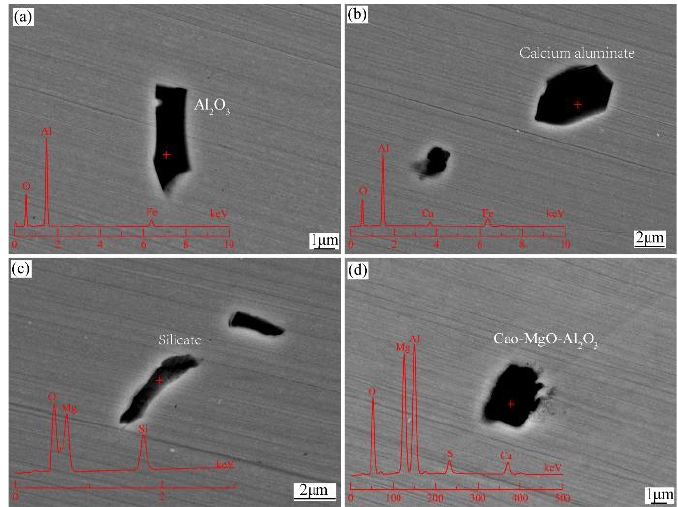
Figure 5. Compositions and morphologies of typical inclusions before Ca addition, ( a ) Al 2 O 3 inclusion, ( b ) Calcium aluminate inclusion, ( c ) Silicate inclusion, ( d ) CaO-MgO-Al 2 O 3 composite inclusion.